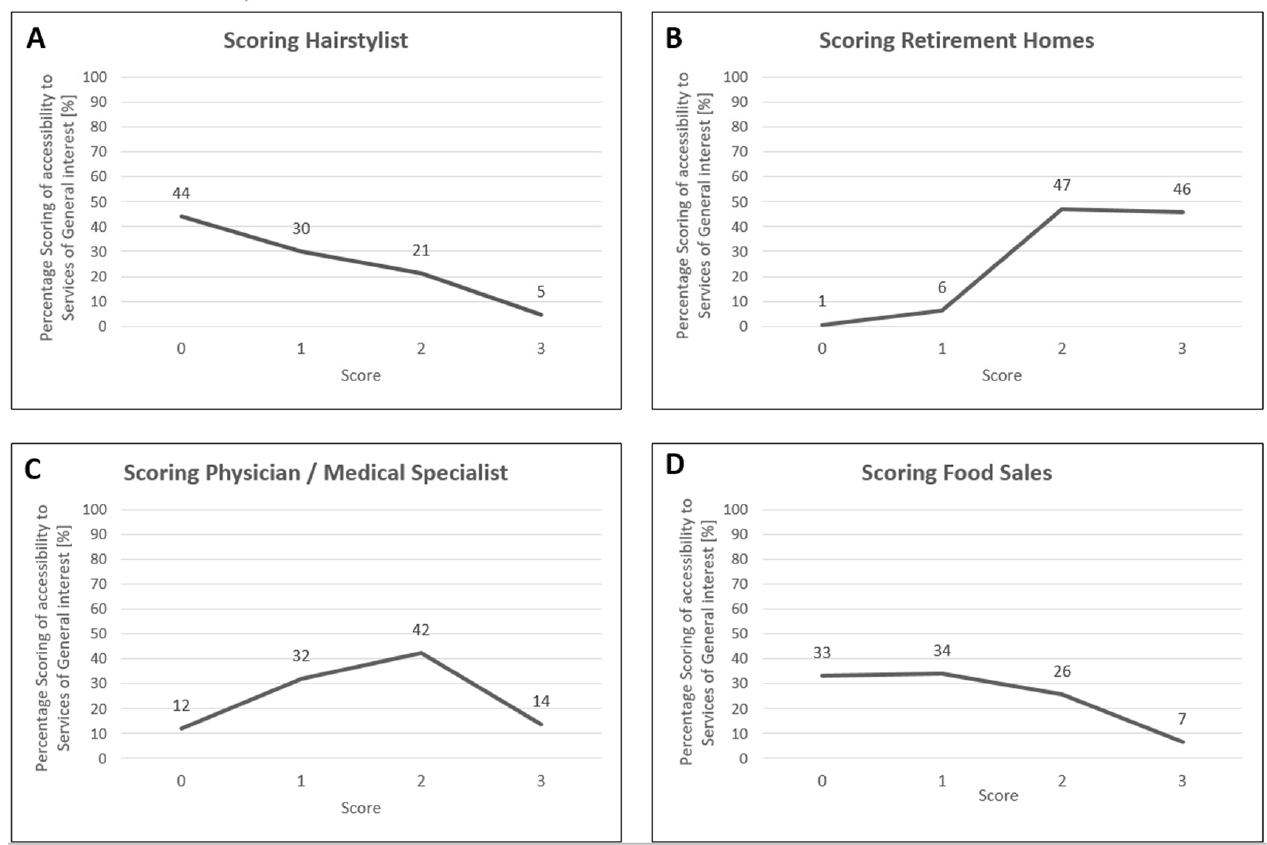
Figure 3. Percentage Scoring of Accessibility to SGI. Source: own figure. ( A ) Scoring of Accessibility to hairstylist within the Rhenish coal-mining area. ( B ) Scoring of Accessibility to Retirement Homes within the Rhenish coal-mining area. ( C ) Scoring of Accessibility to Physicians/Medical Specialist within the Rhenish coal-mining area. ( D ) Scoring of Accessibility to Food sales within the Rhenish coal-mining